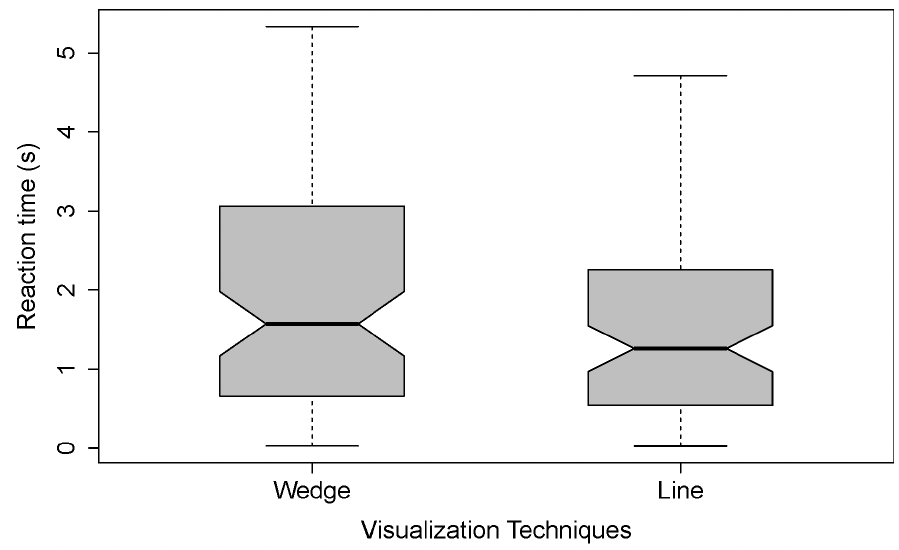
Figure 7. Comparison of reaction times for the two different visualization techniques: Wedge and Line